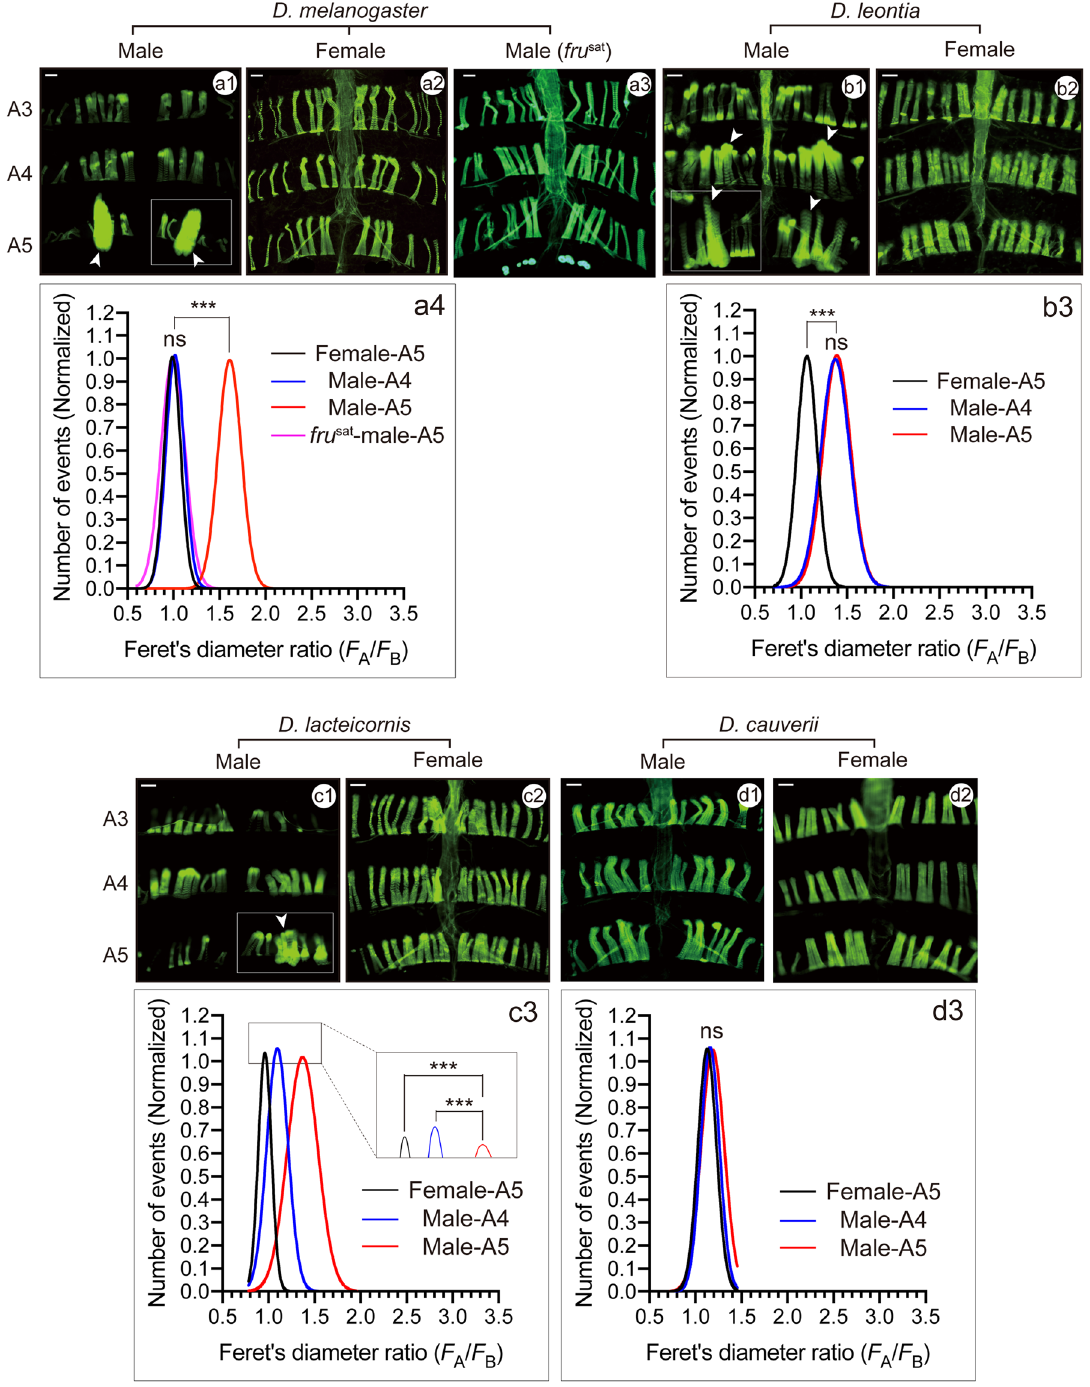
Figure 1. Detection of sexual dimorphism in the abdominal musculature of D. melanogaster and some species of the montium group. Representative images ( a1 – a3 , b1,b2,c1,c2 , d1,d2 ) of abdominal muscles and the Gaussian fit to the F A /F B distribution of the largest muscle ( a4 , b3,c3 , d3 ) in the reference species D. melanogaster ( a ) and 3 species of the montium groups, i.e., leontia ( b ), lactericornis ( c ) and cauverii ( d ). Images are typical examples of male abdominal musculatures with the exception of those for D. melanogaster , which are images of a wild-type male ( a1 ), wild-type female ( a2 ) and fru mutant male ( a3 ). The MOL and its analogs are indicated with arrowheads, and the regions shown in Fig. 4 to visualize nuclei are boxed. D. cauverii is a species that did not show the neuromuscular sexual dimorphism in the A5 segment whereas 3 other species displayed the sexual dimorphism. Scale bar: 100 µm. The curves in a4 , b3 , c3 and d3 compare F A /F B distributions for the male A5 (red lines), the female (black lines) and male A4 (blue lines), and, only in a4 , the male fru mutant A5 (magenta lines). The statistical differences were evaluated by the Brown-Forsythe and Welch ANOVA or Kruskal–Wallis test; *** P <